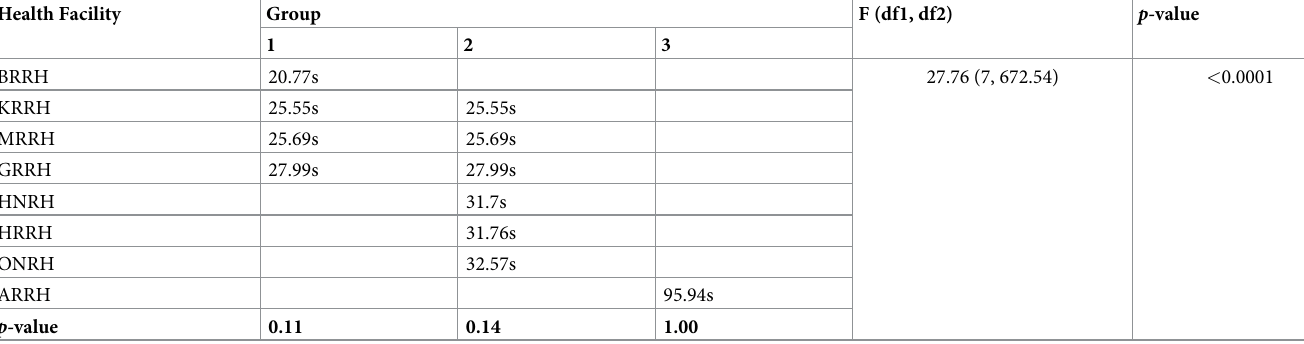
Table 4. Grouping of hospitals as per their homogeneity with regards to the dispensing time (seconds). Health